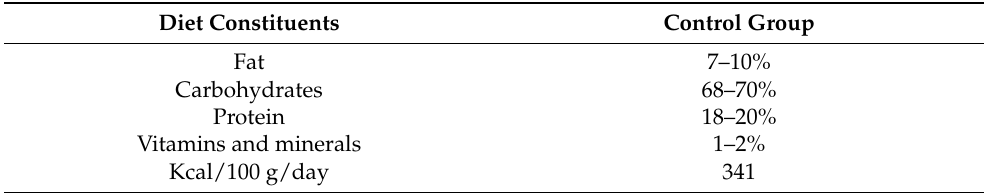
Table 1. Chemical composition of basal standard diet.